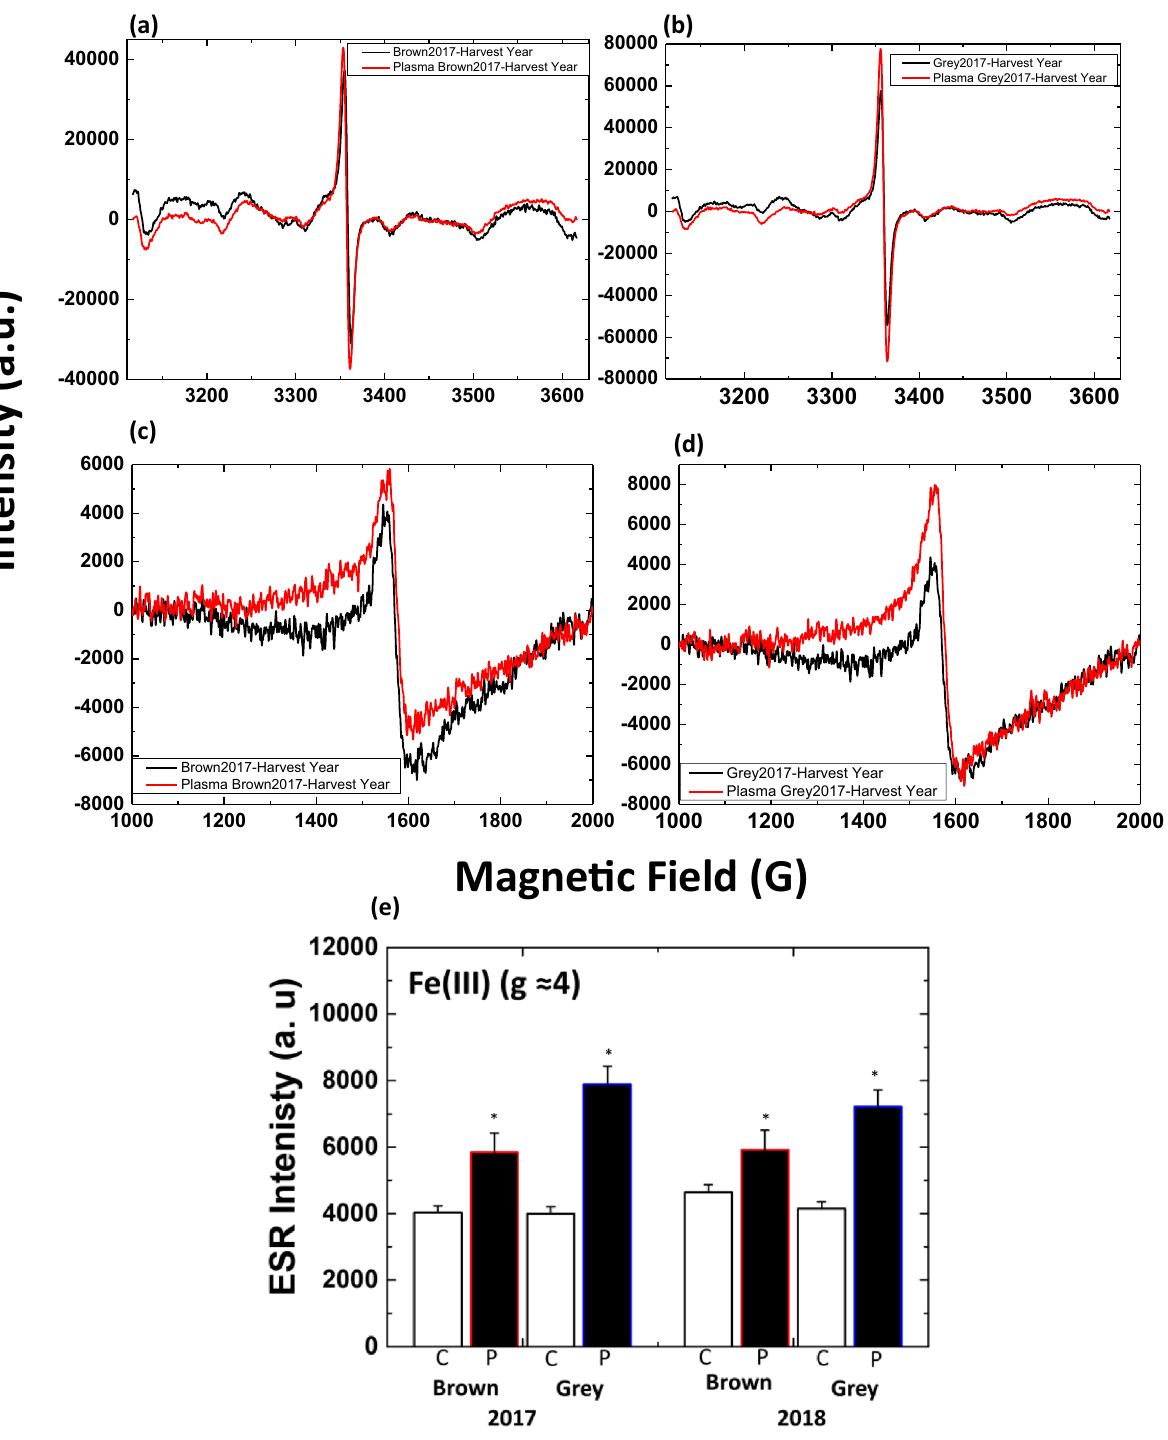
Figure 5. EPR spectra for radish seeds harvested in 2017-at (a) g ≈ 2 brown seeds, (b) g ≈ 2 grey seeds, (c) g ≈ 4 brown seeds, (d) g ≈ 4 grey seeds before (black line) and after plasma treatment (red line), (e) EPR intensity at g ≈ 4, before and after plasma treatment.*Statistically significant difference from the control group (p <